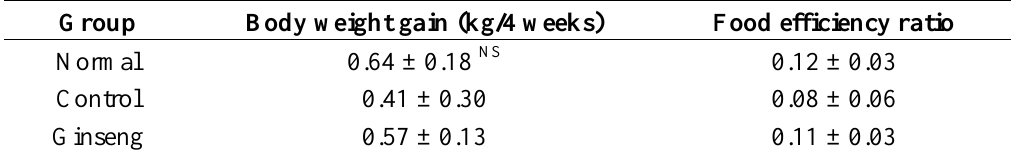
Table 1. Body weight gain and food efficiency ratio in the rabbits fed the experimental